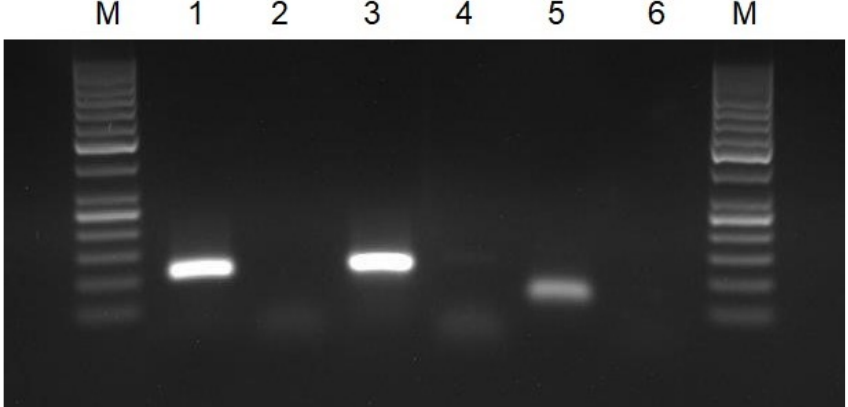
Figure 1. Agarose gel electrophoresis of PCR products: M—molecular DNA marker 100 bp; 1—PCR for gene RdRP (primers nCoV_IP4-14059Fw/Rv); 2—negative control for gene RdRP; 3—PCR for gene E (primers E_Sarbeco_F/R); 4—negative control for gene E; 5—PCR for gene N (primers 2019-nCoV_N2-F/R); and 6—negative control for gene N.